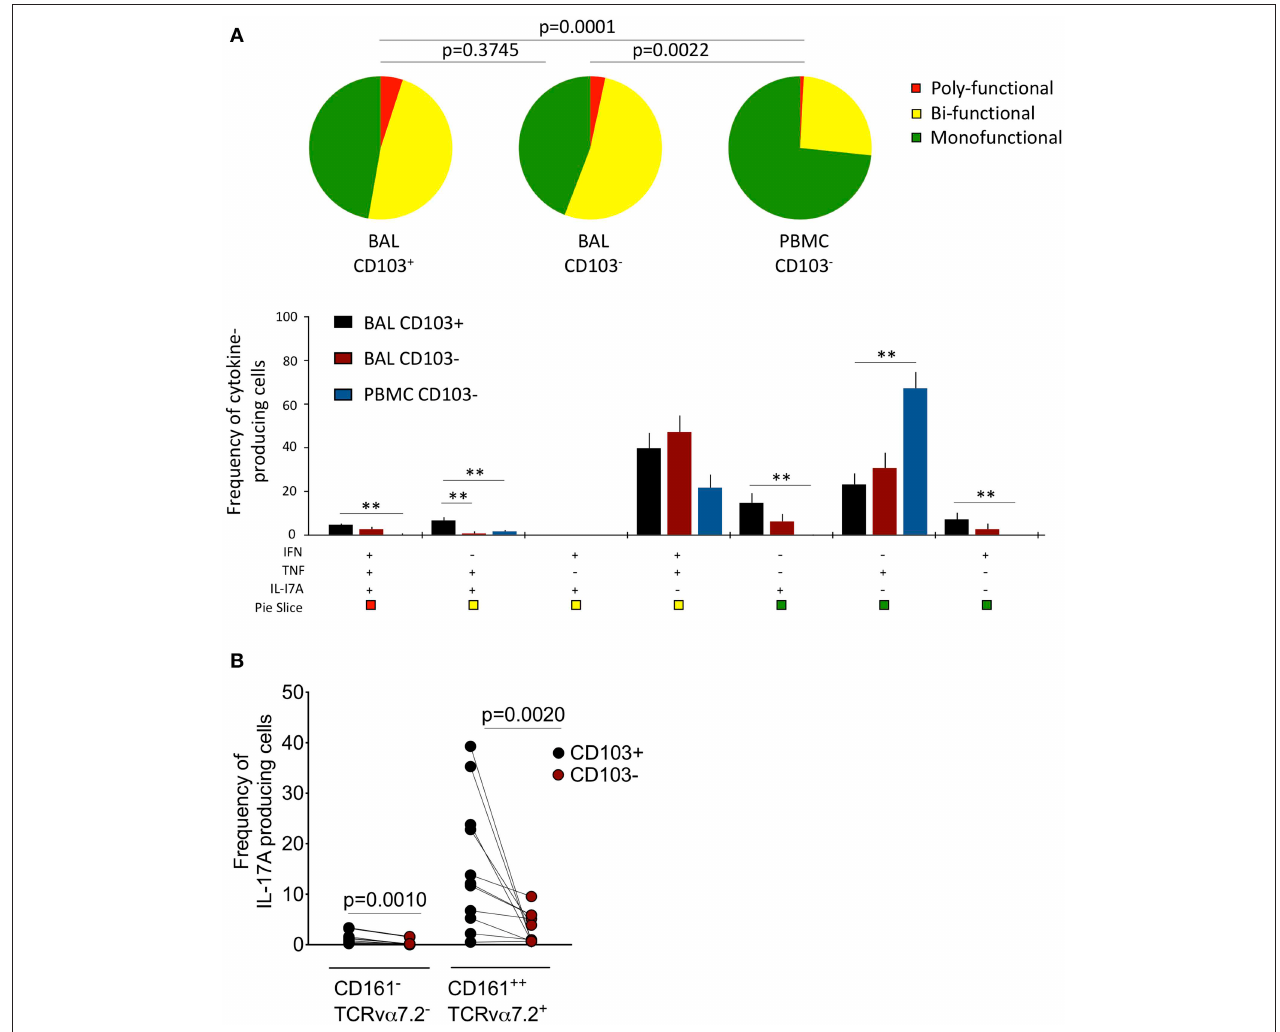
FIGURE 3 | Functional profile of CD8 + CD161 ++ TCRv α 7.2 + T cells in airway lumen and peripheral circulation. BAL cells and PBMCs from HIV-uninfected adults were stimulated with PMA/Ionomycin for 6h and responses were measured by intracellular cytokine staining for TNF, IFN- γ , and IL-17A. The response was obtained by gating on singlets, lymphocytes, viable (LIVE/DEAD Aqua), CD3 + cells, CD8 + cells/ CD8 + CD161 ++ TCRv α 7.2 + T cells and combination of three cytokines. (A) Each pie chart (top) represents the mean distribution across subjects of mono-functional, bi-functional and poly-functional cytokine producing cells (color coded as shown) within the total response in a particular CD161 ++ TCRv α 7.2 + T cell population. Bar charts (bottom) represent the mean and standard error of the mean (SEM) of the contribution of the indicated subset (x-axis) toward the total response against the indicated CD161 ++ TCRv α 7.2 + T cell subsets (color coded as shown). Permutation test was performed among the pie charts and Wilcoxon test was done among the bar charts using SPICE software (* p < 0.05, ** p < 0.01). (B) Frequency of IL17A-producing cells in the CD103 + or CD103 − CD8 + T cell/CD8 + CD161 ++ TCRv α 7.2 + T cell populations subtracting background responses obtained from the non-stimulated controls. The horizontal bars represent median, interquartile range and highest/lowest value. Data were analyzed using Mann Whitney test ( n = 11). BAL, bronchoalveolar lavage; IFN, interferon-gamma; TNF, tumor necrosis factor; IL17,